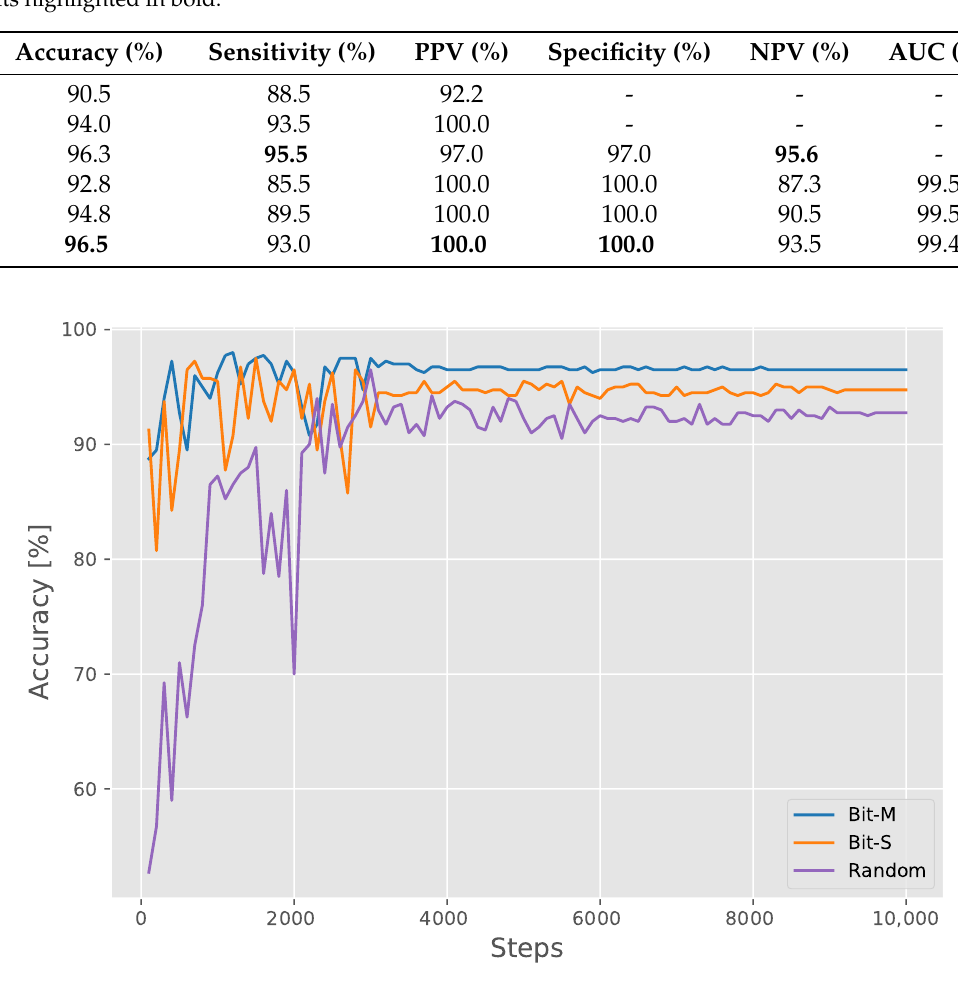
Figure 5. Test accuracy curves for models with different initialization